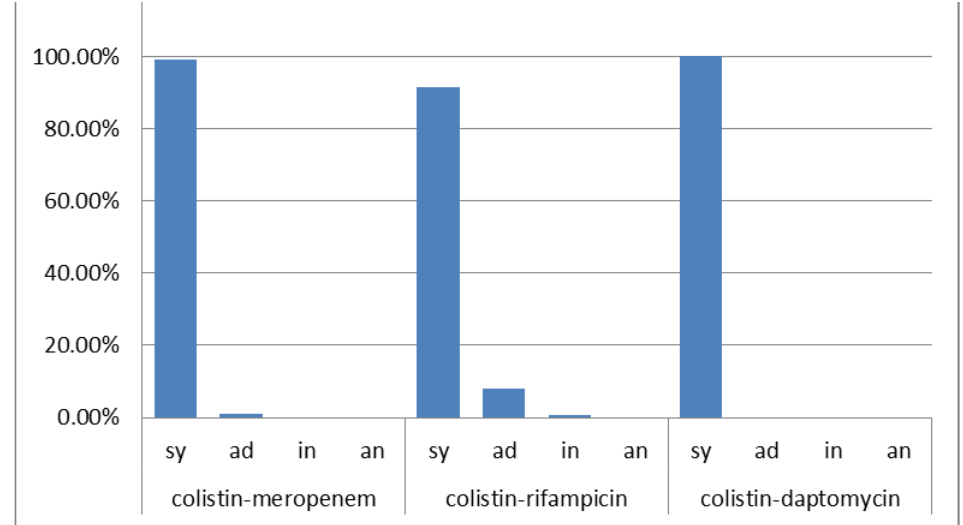
Figure 1. The% results of antimicrobial combinations tested for A. baumannii . sy: synergy; ad: addi-